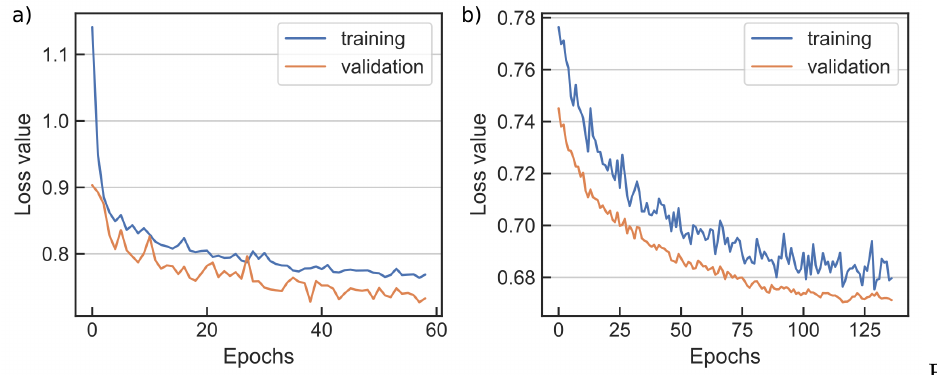
Figure 9. Training and validation loss values for a DNN classifier during transfer learning: ( a ) net- work training phase, ( b ) network fine-tuning